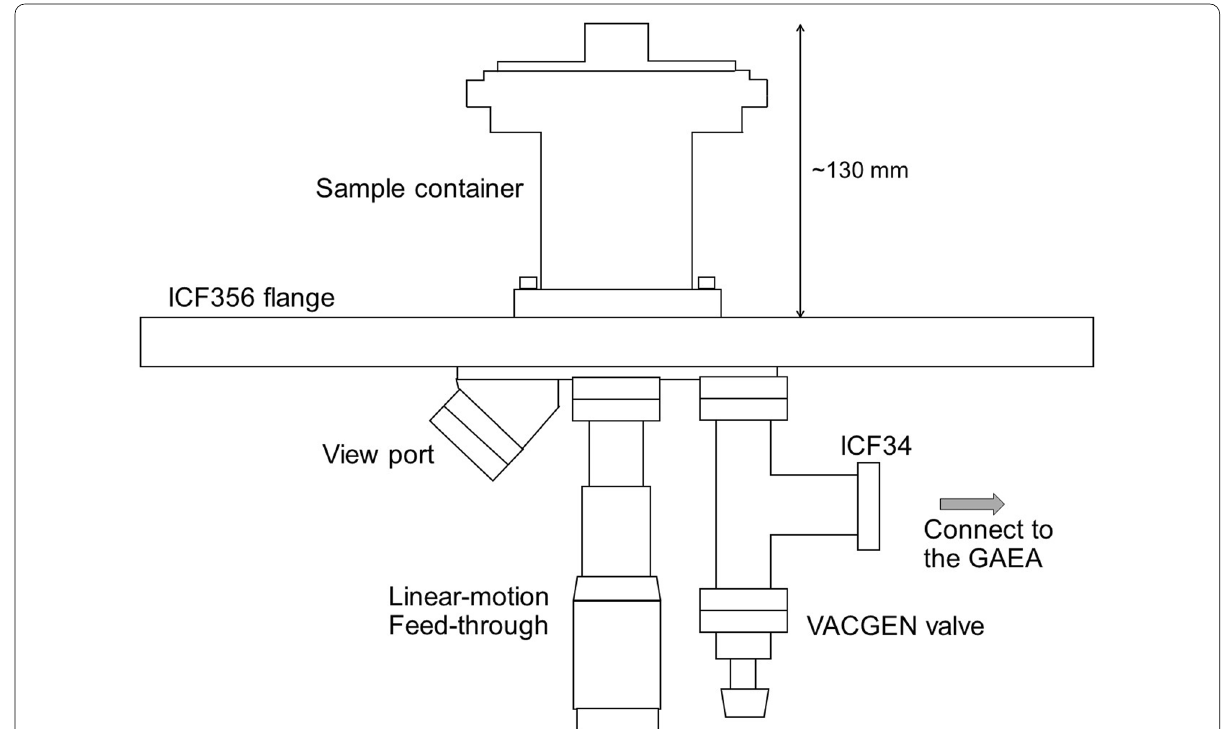
Fig. 1 Schematic drawing of the Hayabusa2 sample container mounted on the ICF356 flange. The flange is equipped with a linear motion feed-through, a view port, and a metal valve (VACGEN ZCR20). It is connected to the GAEA via the ICF34 port of the